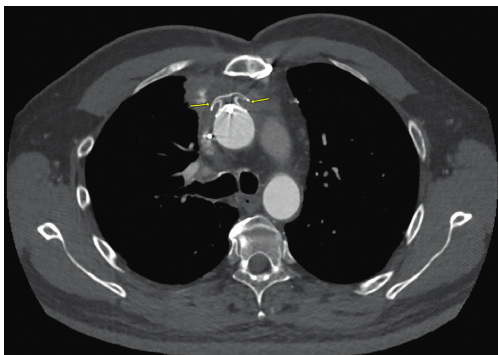
Figure 3: Computed tomography angiography demonstrating no overt contrast flow around a well-sealed ASD Amplatzer occlusion device within the ascending aortic anterior pseudoaneurysm one month following the procedure.